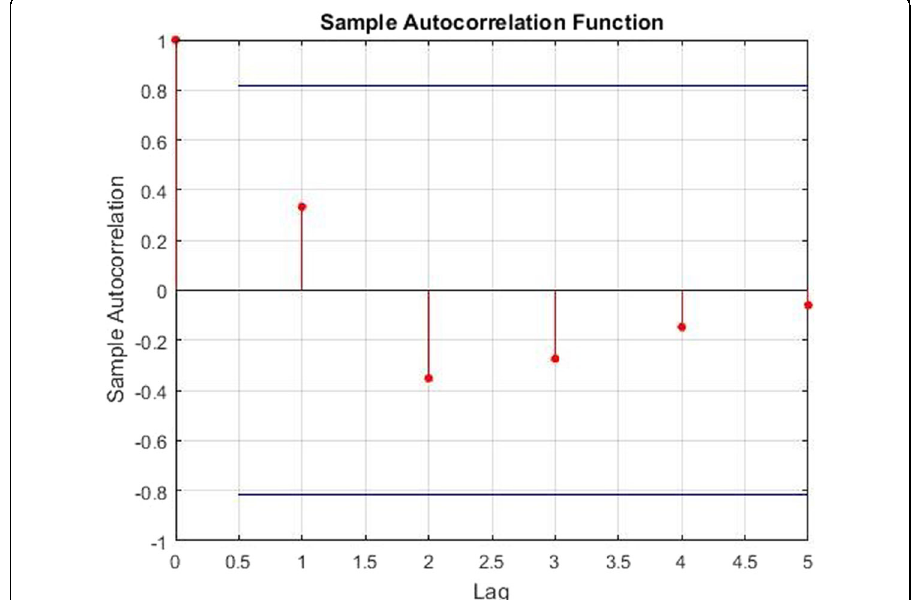
Fig. 3 Auto-correlation plot of prediction errors in 5-days time